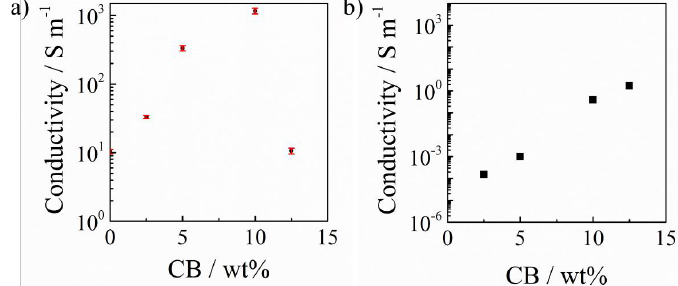
Figure 4. Variation of electronic conductivity as a function of carbon black (CB) weight ratio in the PAI/polyaniline (PANI)/CB ternary ( a ) and PAI/CB binary ( b ) conductive polymer composites. Previously, we fabricated a series of PAI/PANI conductive polymer composites [17], and the conductive property of PAI/PANI polymer composites was clearly improved compared with pure